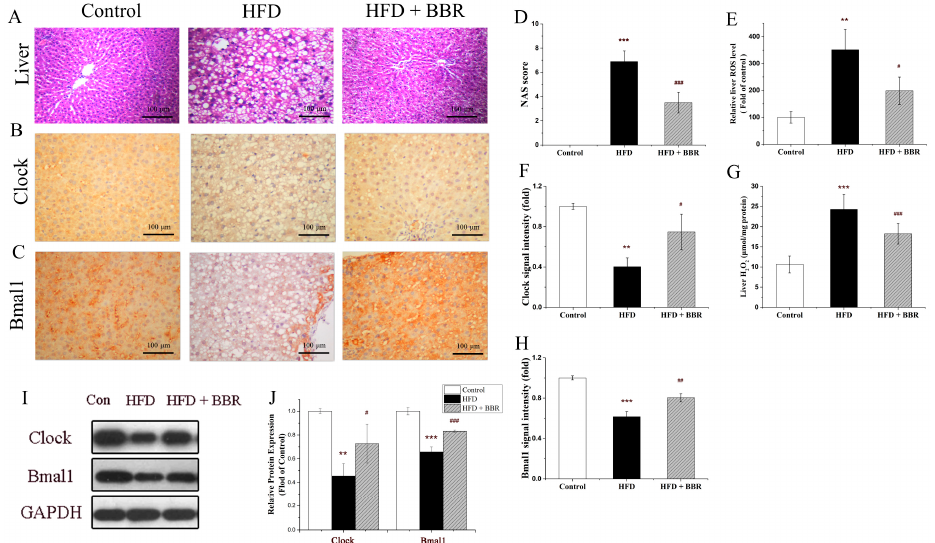
Figure 2. BBR improved liver pathology, ROS level, H 2 O 2 level, and enhanced the expression of Clock and Bmal1 proteins in vivo. ( A ) Liver H&E staining; ( B ) IHC of Clock; ( C ) IHC of Bmal1; ( D ) liver NAS score; ( E ) liver ROS level; ( F ) relative Clock protein expression by IHC; ( G ) liver H 2 O 2 level; ( H ) relative Bmal1 protein expression by IHC; ( I ) Clock, Bmal1, and GAPDH protein bands; ( J ) relative Clock and Bmal1 protein expression by Western blot. Data are presented as the mean value ± SE ( n ≥ 6): ** p < 0.01, and *** p < 0.001 compared to the control group. # p < 0.05, ## p < 0.01, and ### p < 0.001 compared to the HFD